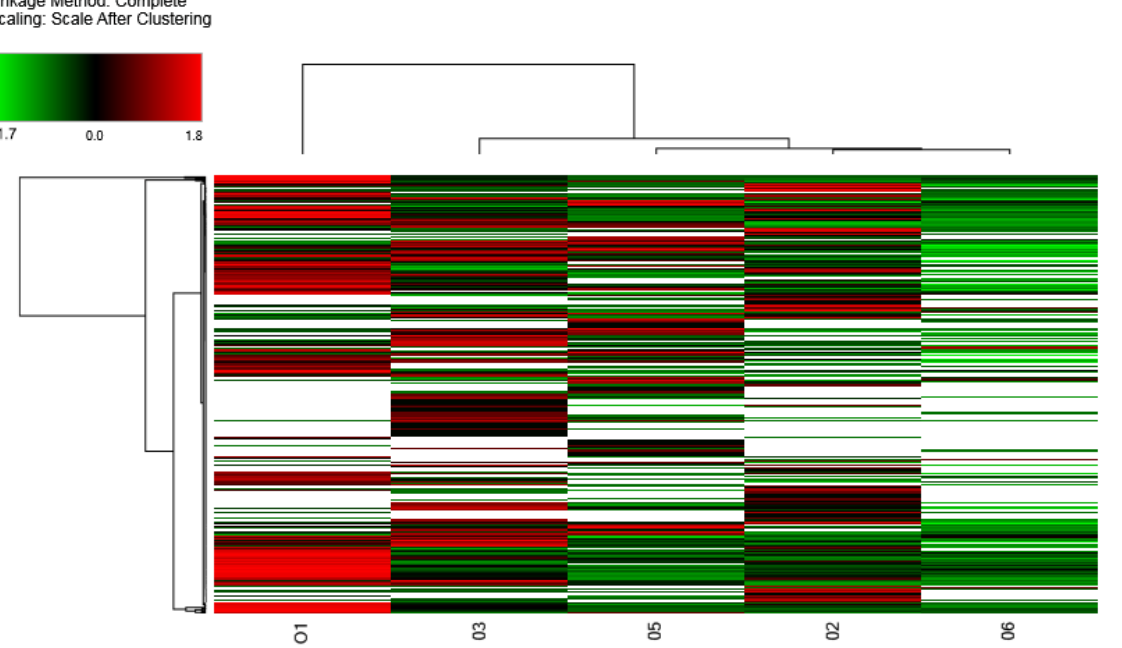
Figure 3. Heatmap from the shotgun proteomics analysis of the different mucus samples (O1, O2, O3, O5, and O6). Every bar corresponds to the presence or absence of a particular protein. Euclidean hierarchical distances were sorted for all samples..